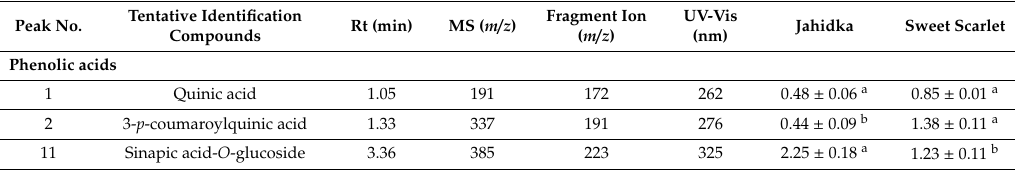
Table 1. Summary of qualitative and quantitative data of the polyphenolic profile in leaves of Elaeagnus multiflora